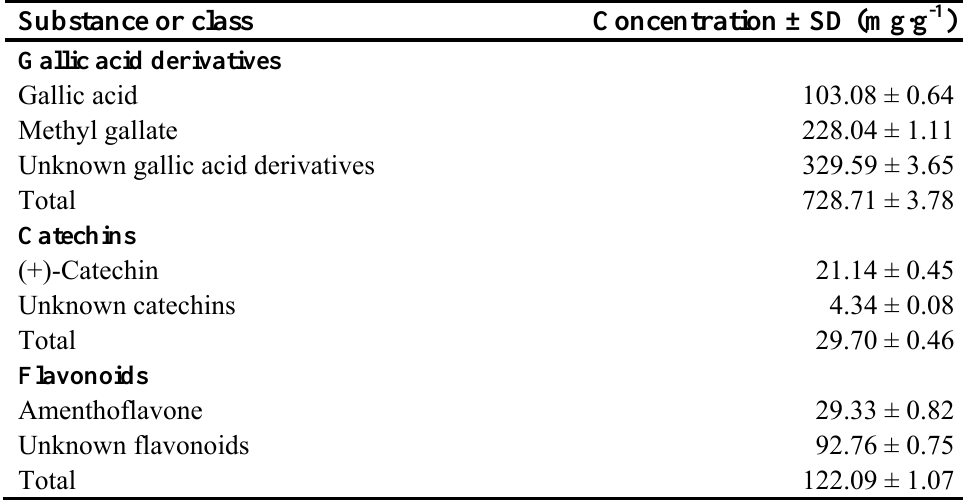
Table 1. Concentration of the secondary metabolites present in the AcF from A. humile St.